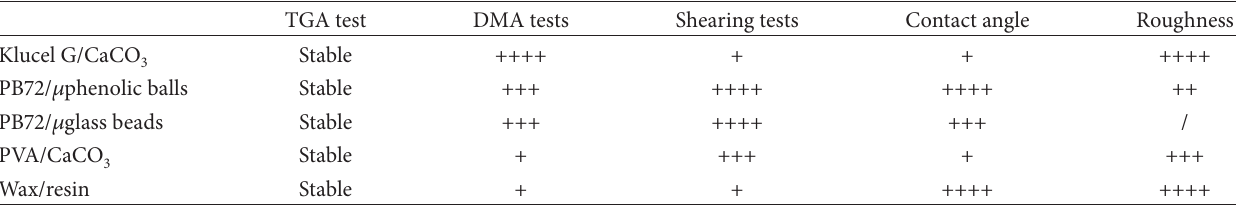
Table 5: Overall properties of tested